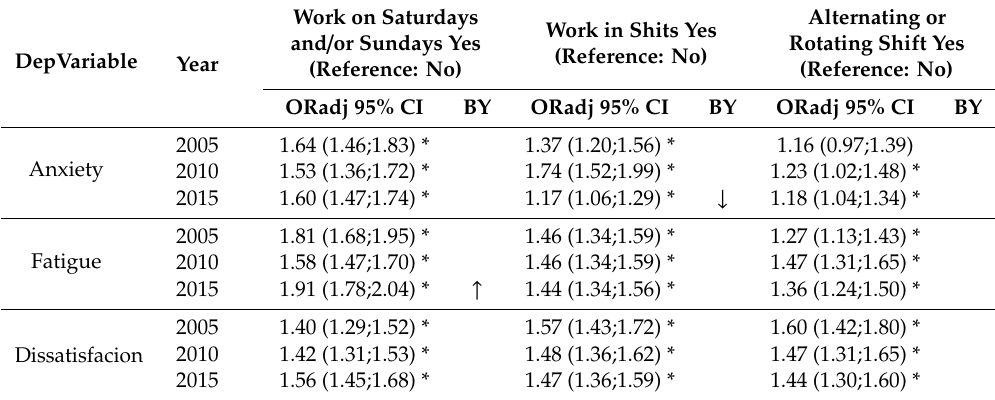
Table 4. Relationship between well-being and atypical working days, shift work and alternating / rotating shifts in 2005–2015.